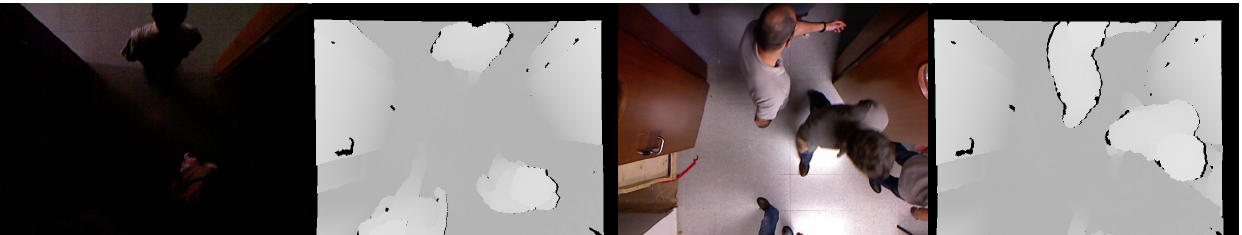
Figure 11. RGB and depth shots exhibiting hard illumination conditions.